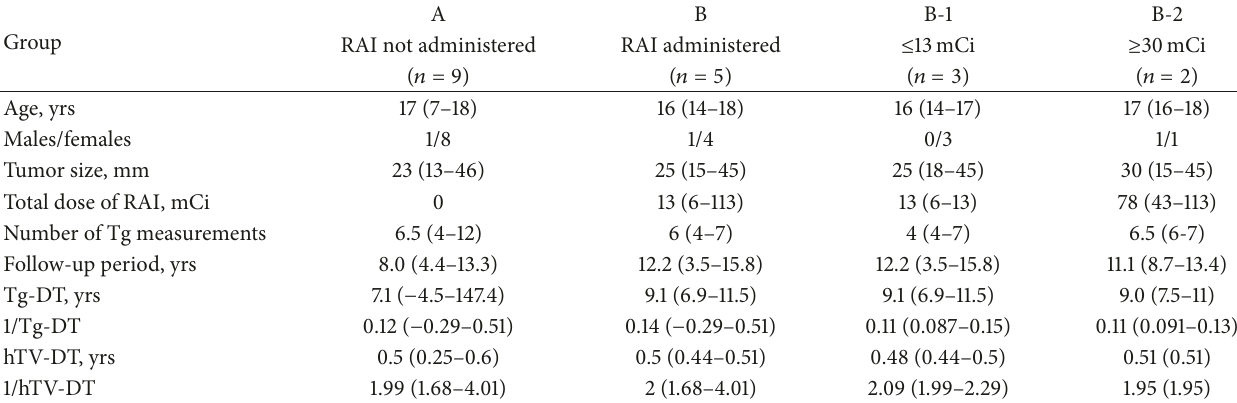
Table 2: Comparison of clinical and biochemical features among the patients with and without RAI